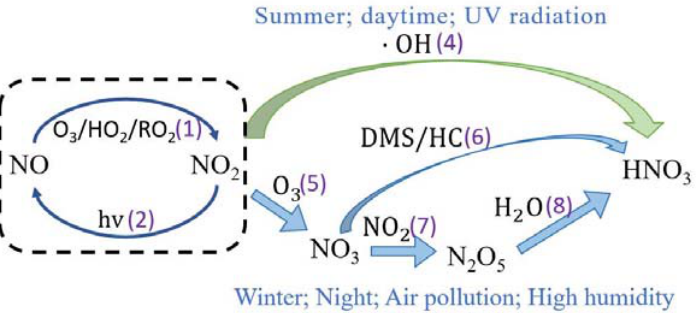
Figure 1. Two reaction pathways for the formation of nitrate from NO X in the air [10,11]. In this figure, (1) to (6) correspond to the corresponding reactions (1) to (6) below.